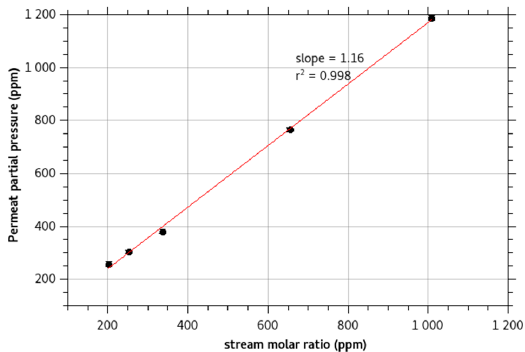
Figure 3. Monochloramine permeate concentration for different feed solution concentration. The line is the calculated calibration curve of the signal. The slope is the enrichment of the membrane.